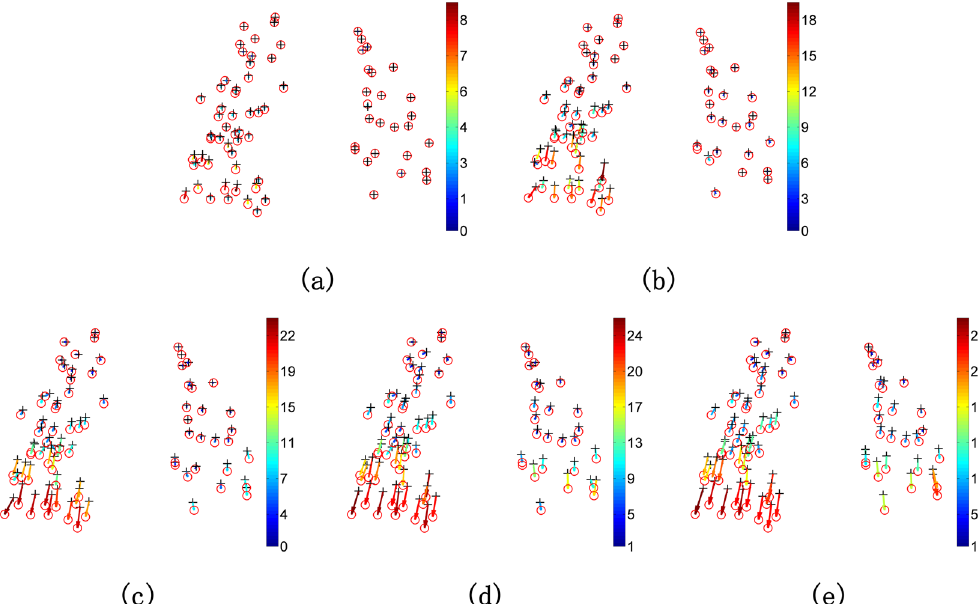
Figure 10. Performance of DSMM on a 4D point set from 4D CT for thoracic motion modeling. 75 points are identified from each expiratory phase image (T00, T10, T20, T30, T40 and T50), where T00 are from the maximum inhalation phase, and T50 are from the exhalation phase image. We also denote the points from the maximum inhalation phase with red “o” and points from other phase with black “ + ”. ( a ) Performance of DSMM on a point set between T00 and T10, ( b ) T00 and T20, ( c ) T00 and T30, ( d ) T00 and T40, ( e ) T00 and